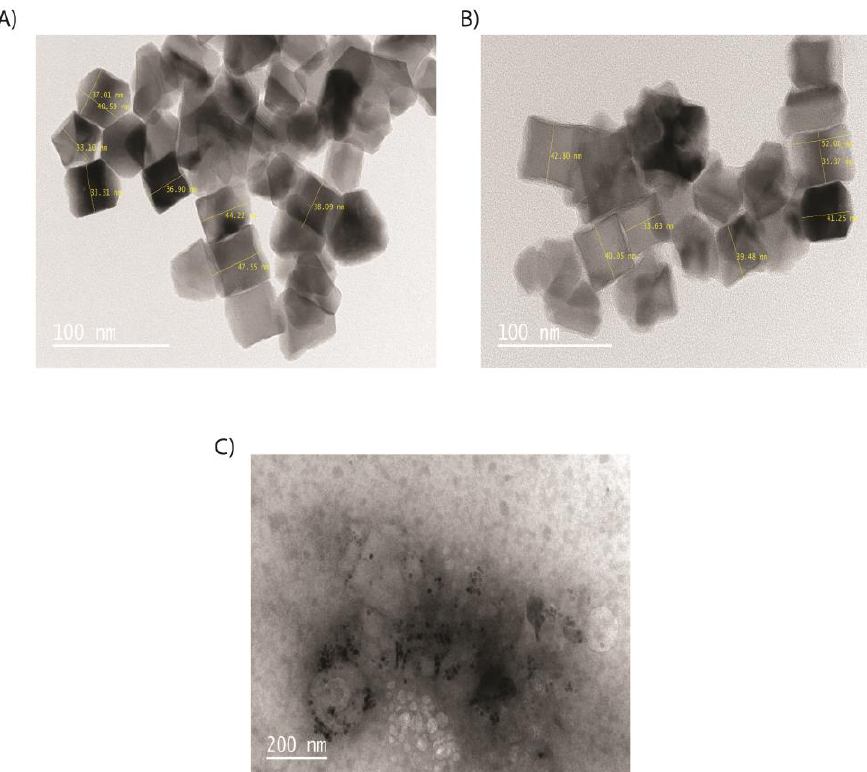
Figure 3. TEM images of NPs and nanoconjugates: ( A ) C-Fe 3 O 4 NPs, ( B ) cubic silica-coated Fe 3 O 4 NPs, and ( C ) cubic HPG-modified and silica-coated Fe 3 O 4 NPs.